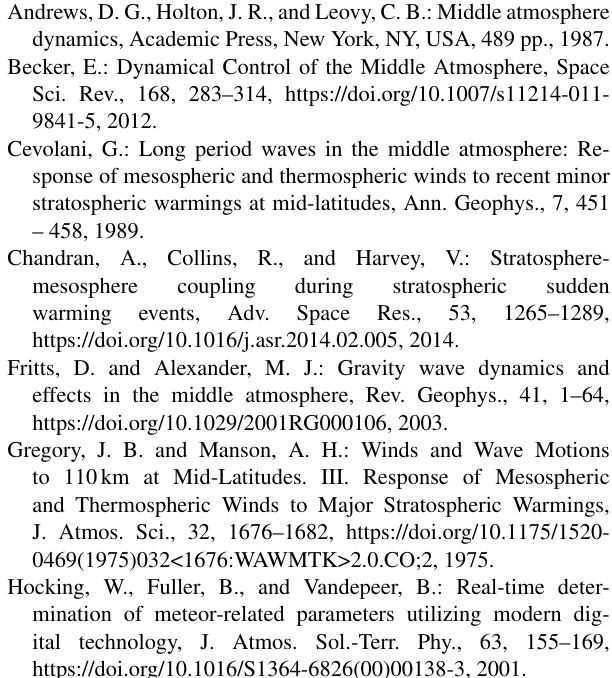
SPW1 was constant and thus the reversed meridional